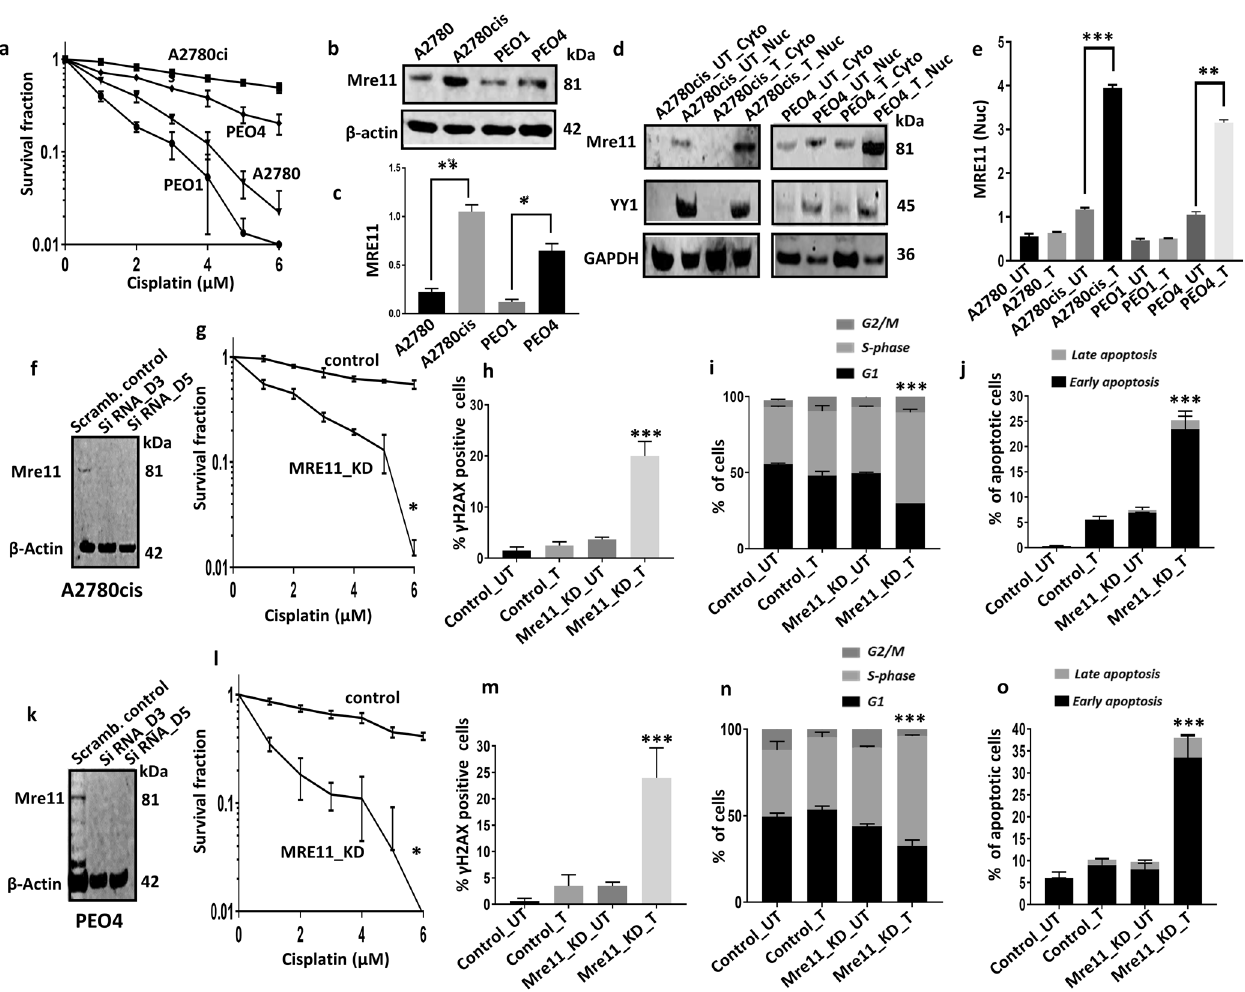
Fig. 2 MRE11 depletion and cisplatin sensitivity in ovarian cancer cells. a Clonogenic survival assay for cisplatin sensitivity in A2780, A2780cis, PEO1 and PEO4 cell lines. b Western blot showing MRE11 protein levels in A2780, A2780cis, PEO1 and PEO4 ovarian cell lines. c Quanti fi cation of Mre11 protein levels by western blot in A2780, A2780cis, PEO1 and PEO4 cell lines. Normalization to β -Actin for the quanti fi cation of the Mre11 in western blot bands were performed. d Mre11 levels in nuclear and cytoplasmic extracts of A2780cis and PEO4 treated with 5 µM cisplatin. Lysates were collected 24 h post treatment (UT = untreated with cisplatin, T = treated with cisplatin). e Mre11 protein levels in nuclear extracts of A2780, A2780cis, PEO1 and PEO4 cells treated with 5 µM cisplatin for 24 h. f Mre11 siRNA knock down in A2780cis cells. Lysates were collected at day3 and day5. g Clonogenic survival assay for cisplatin sensitivity in A2780cis cells control and A2780cis_MRE11_KD cells. h Quanti fi cation of γ H2AX positive cells by fl ow cytometry. i Cell cycle analysis by fl ow cytometry. j